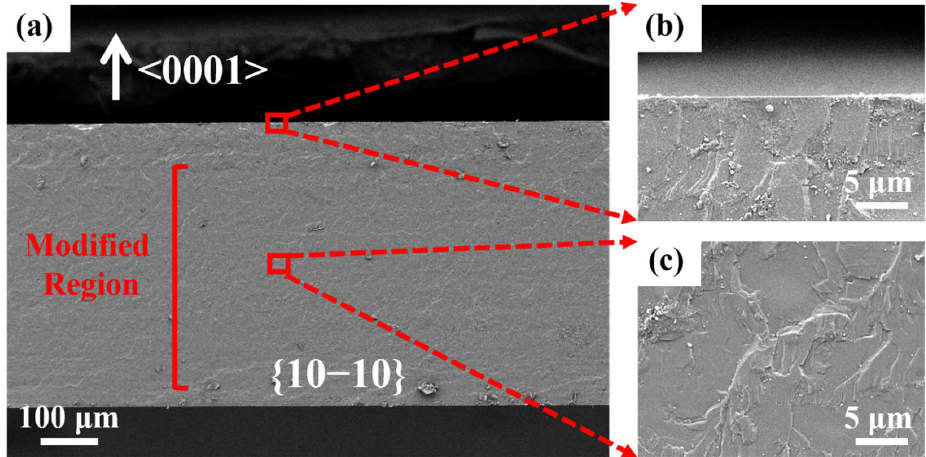
Figure 6. SEM images of ( a ) cross section of the SiC wafer after PLSD, ( b ) enlarged view near the top surface, and ( c ) enlarged view at the center of the modified